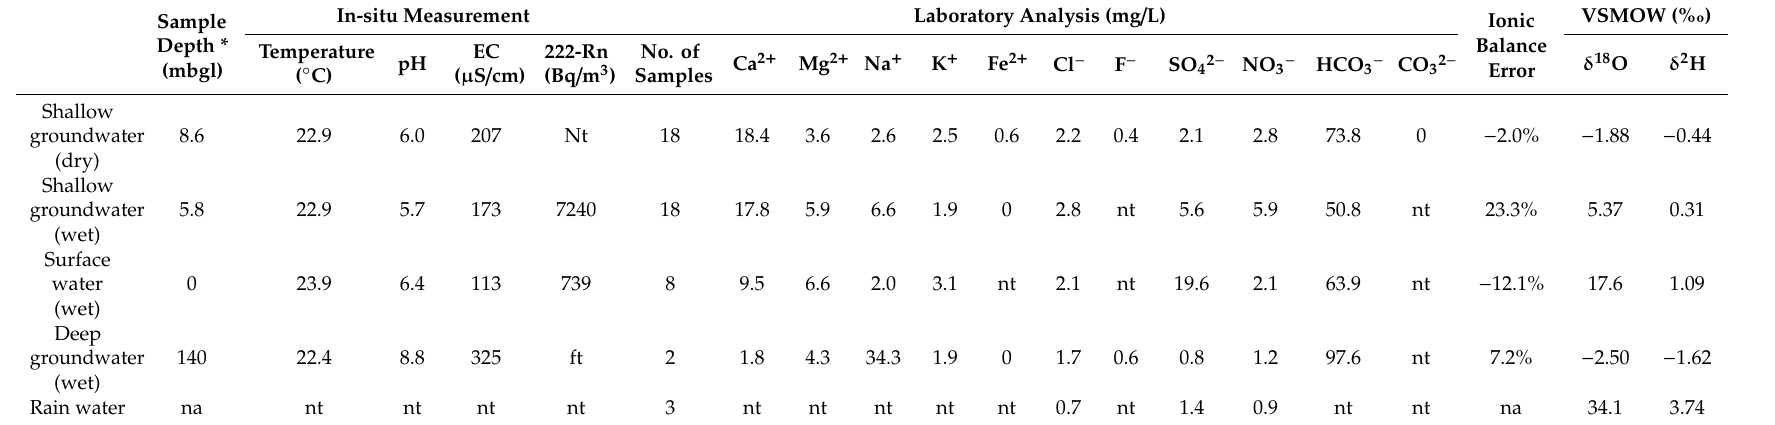
Table 2. Average values of measured hydrochemical parameters per water source and